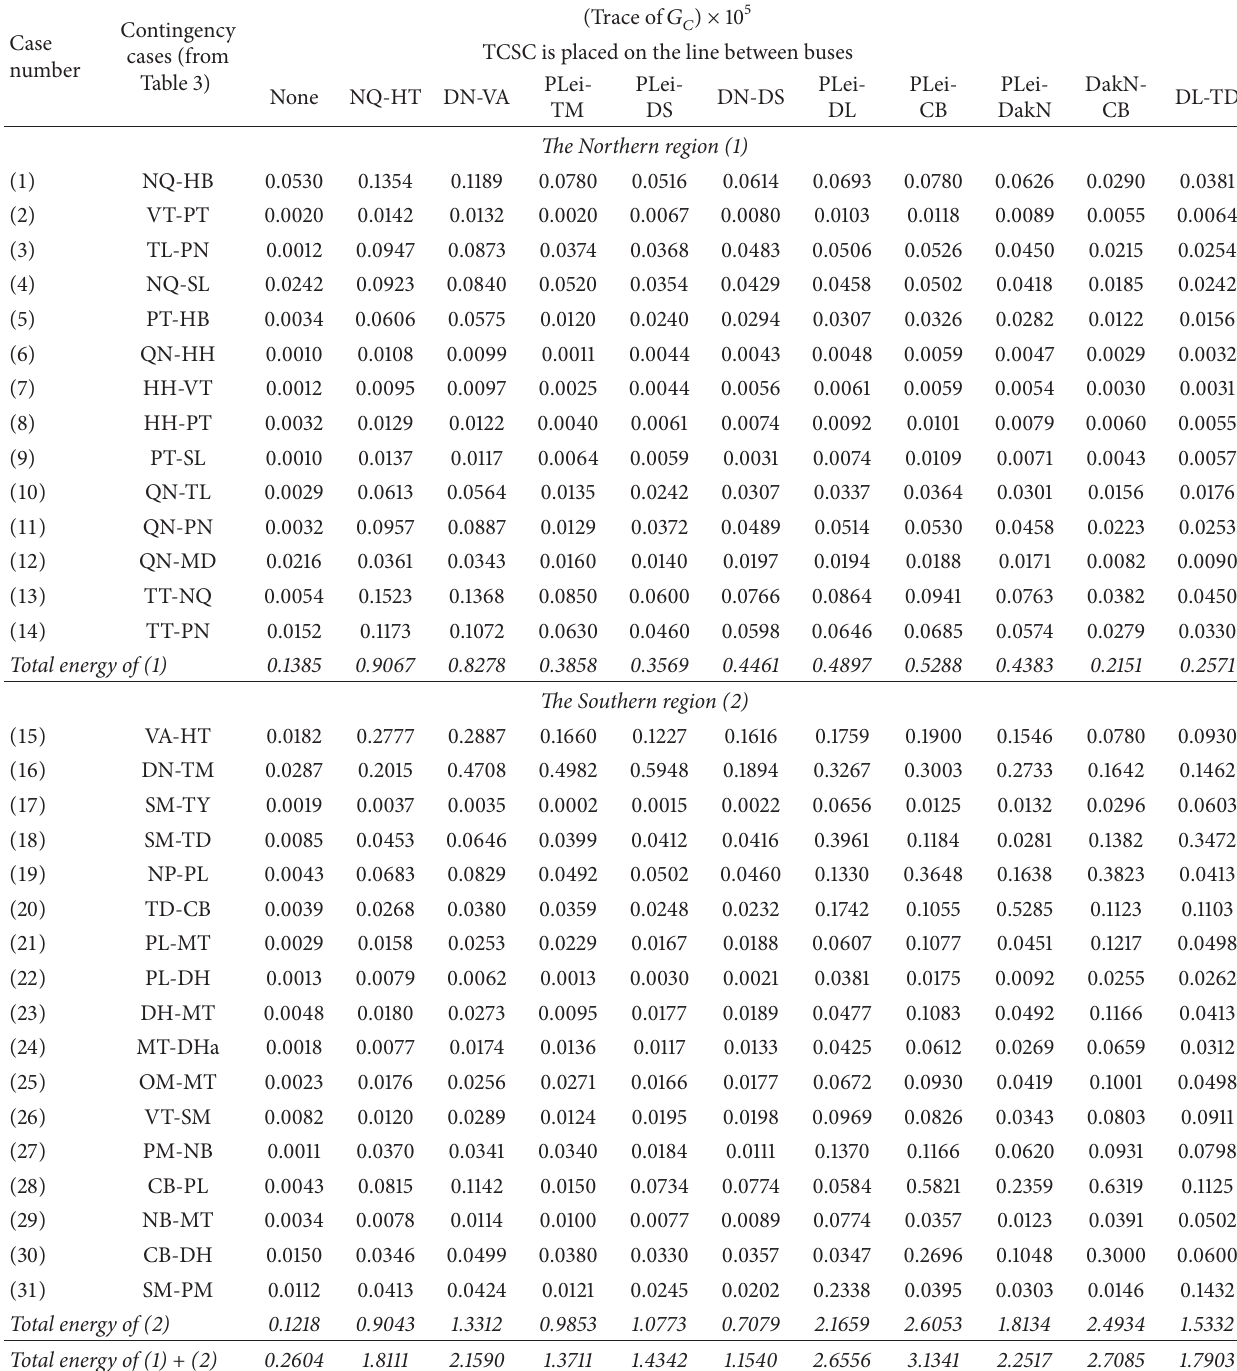
Table 4: Energy values according to several feasible locations of